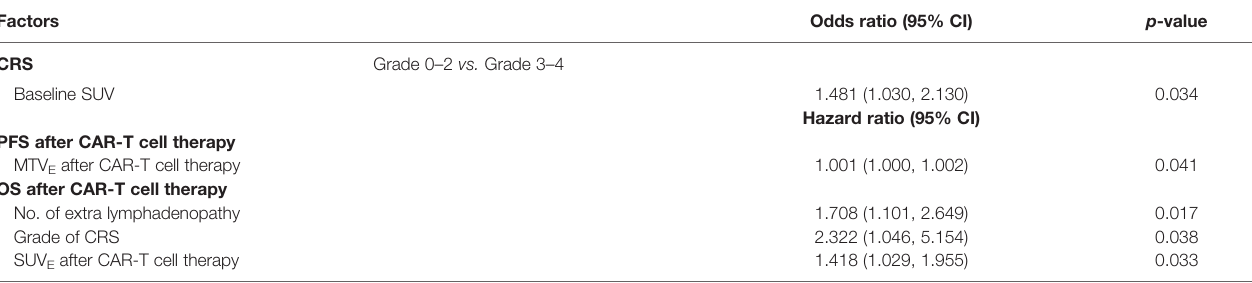
TABLE 2 | Multivariate analysis for risk factors associated with CRS, PFS, and OS.